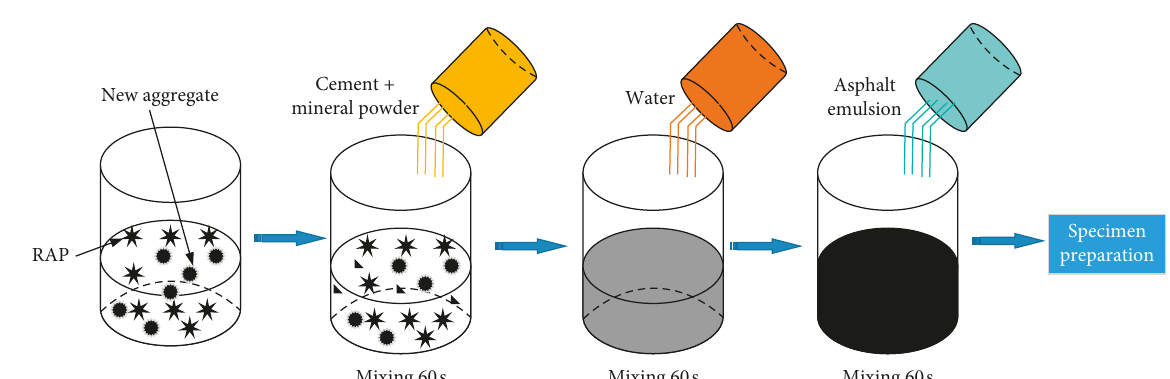
Figure 2: Preparation process of the